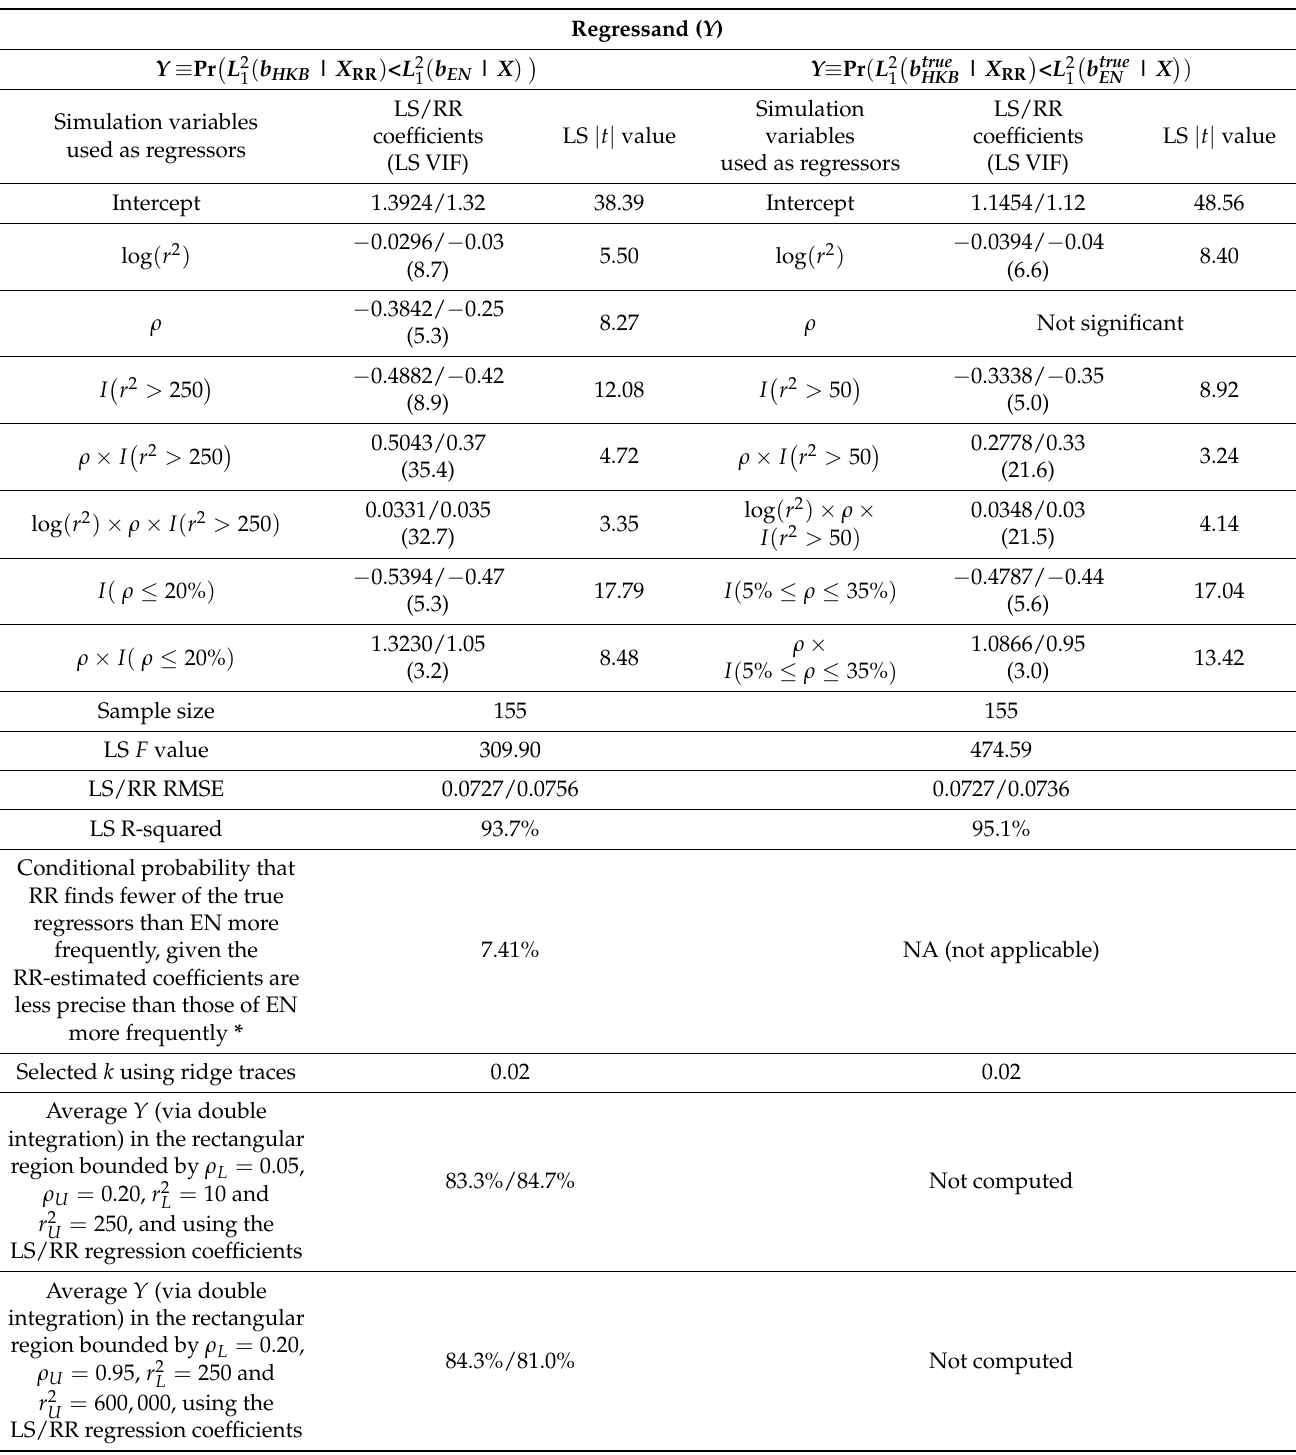
Table 3. Approximating patterns in simulated hit rates, ω ∼ =